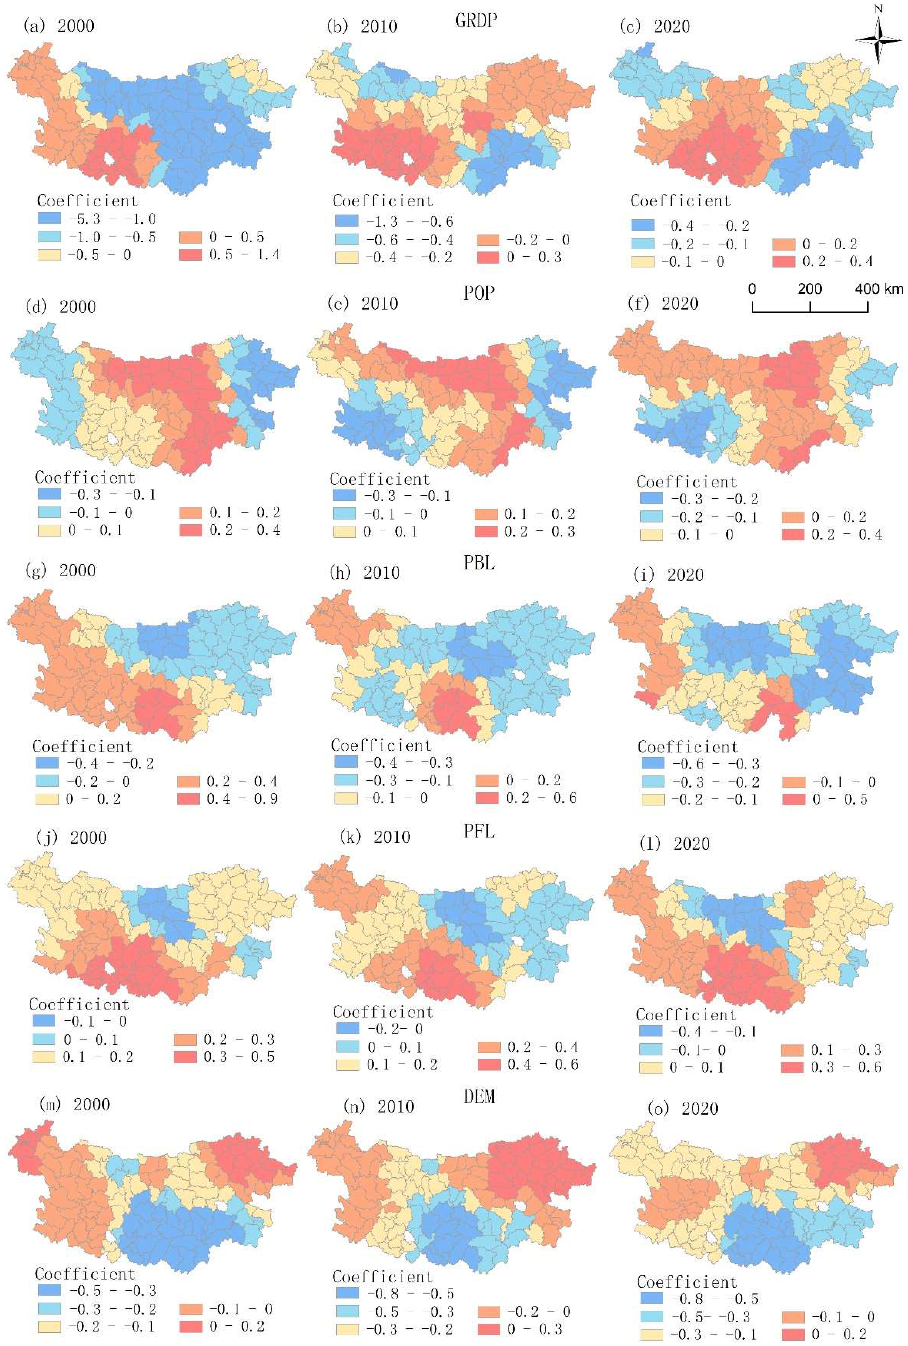
Figure 6. Spatial distribution patterns of correlation coefficients between ecosystem health and driv- ing factors from 2000 to 2020. ( a – c ) GRDP: Gross regional domestic product. ( d – f ) POP: Population size. ( g – i ) PBL: Proportion of built-up land. ( j – l ) PFL: Proportion of forest land. ( m – o ) DEM: Digital elevation model, reflecting elevation.